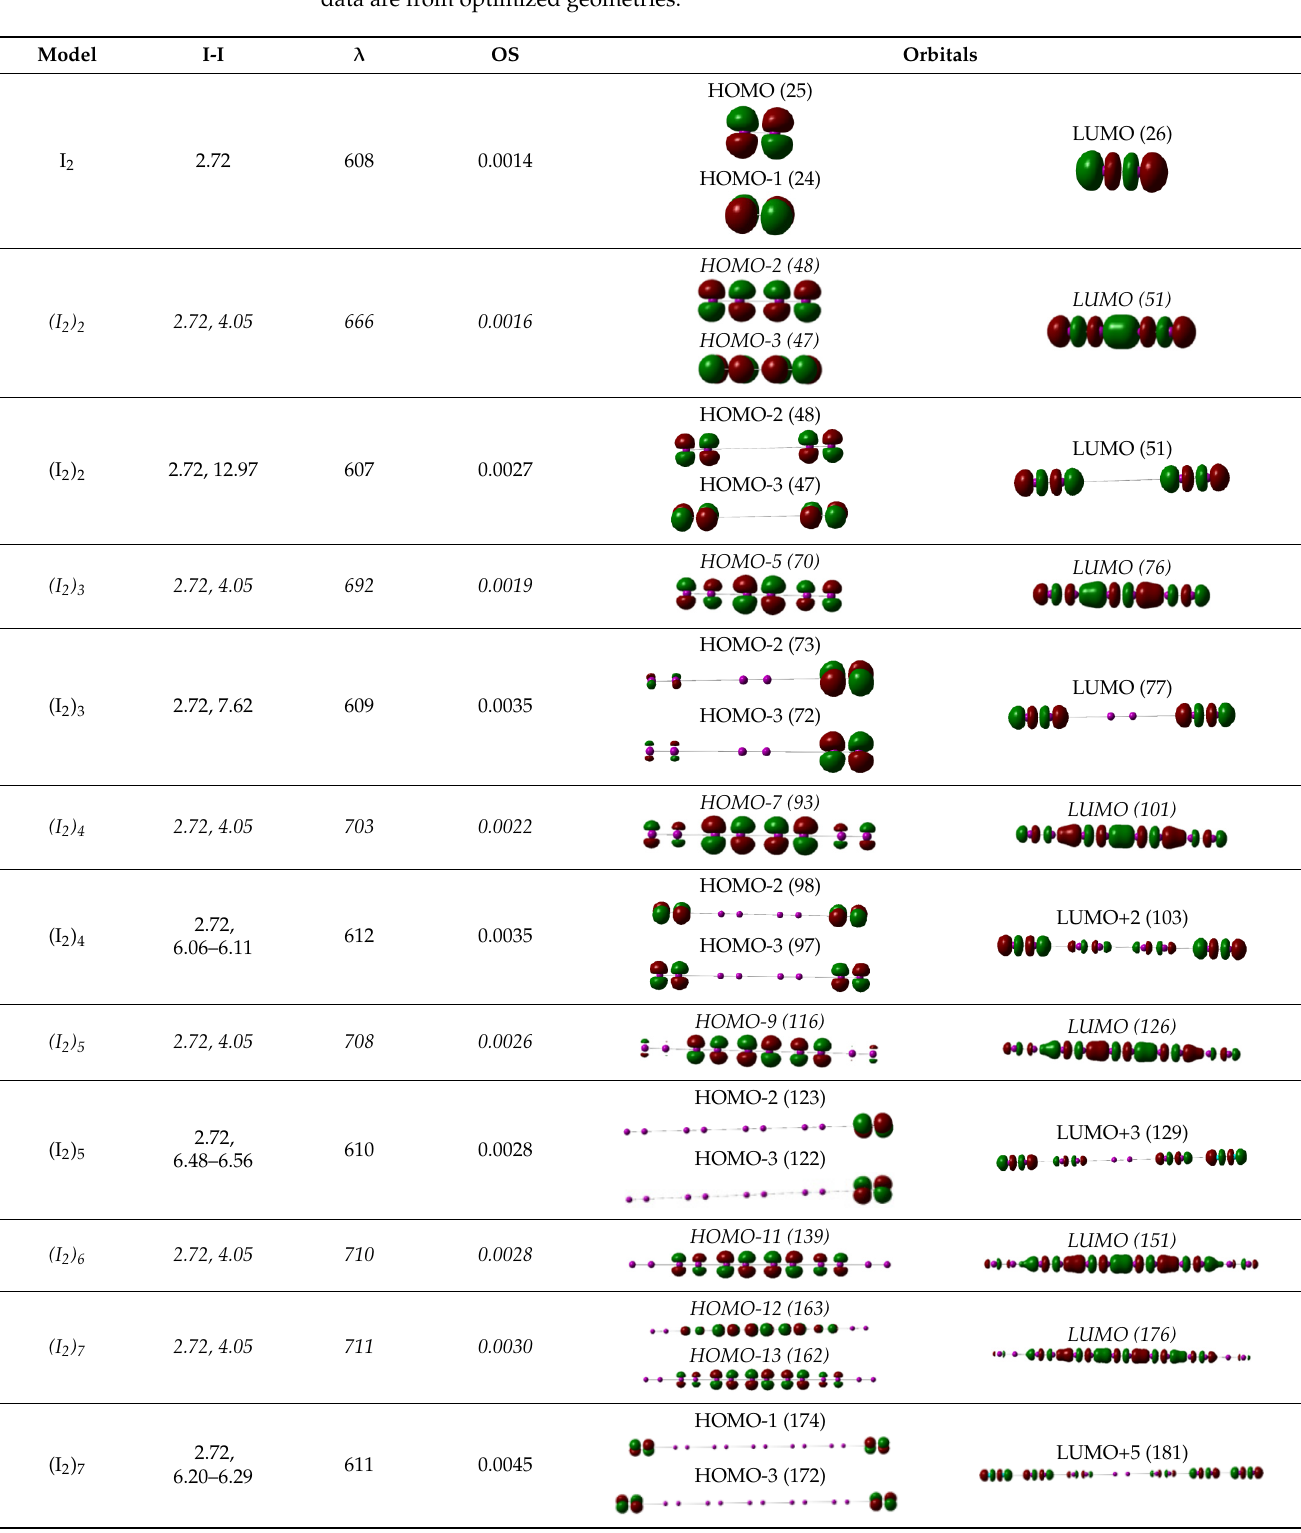
Table 2. I-I distances (Å), wavelengths for the major maximum in the visible region (nm), oscillator strengths (OS) and relevant molecular orbitals on linear I n - models from TD-DFT (B3LYP/def2- SV(P)) calculations. Data shown in italics are from single-point calculations on structures built with intramolecular I-I distances known experimentally for I 2 in solid state (2.72 Å). All other data are from optimized geometries. Model